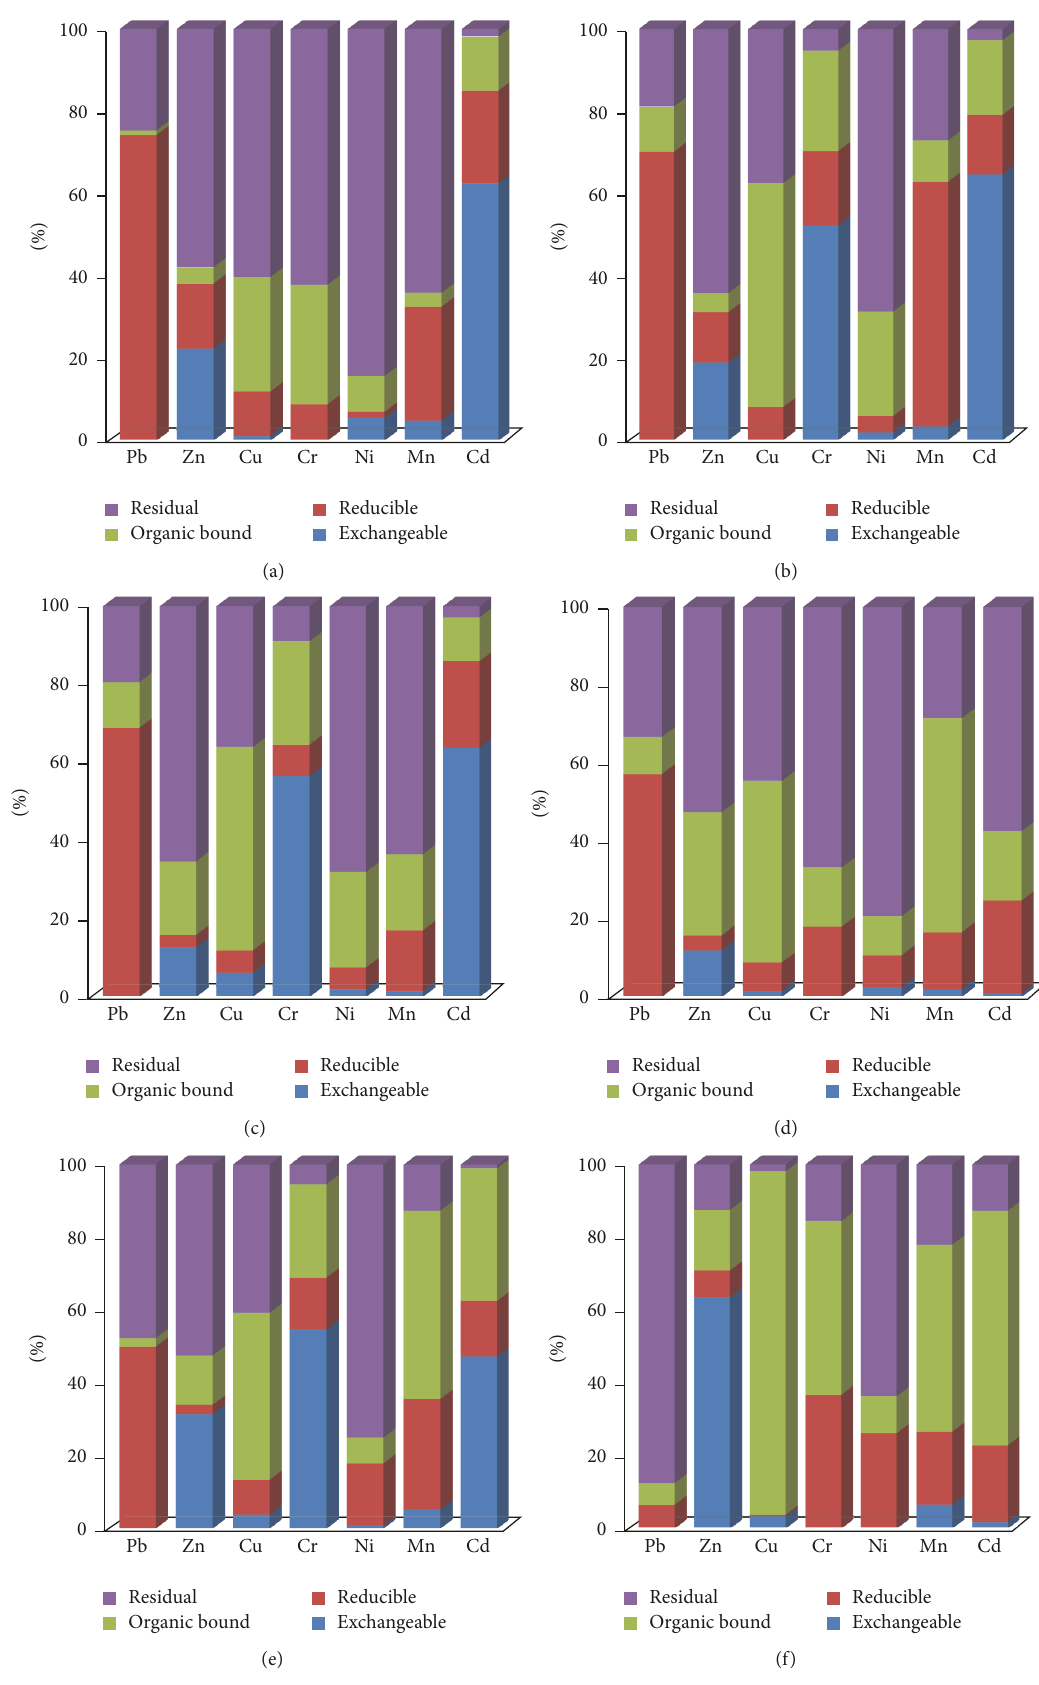
Figure 1: Distribution of metals in different geochemical fractions in dust samples at the sampling sites within Akure Metropolis. (a) AKOB; (b) AKOA; (c) AKEX; (d) AKAL; (e) AKOR; (f)